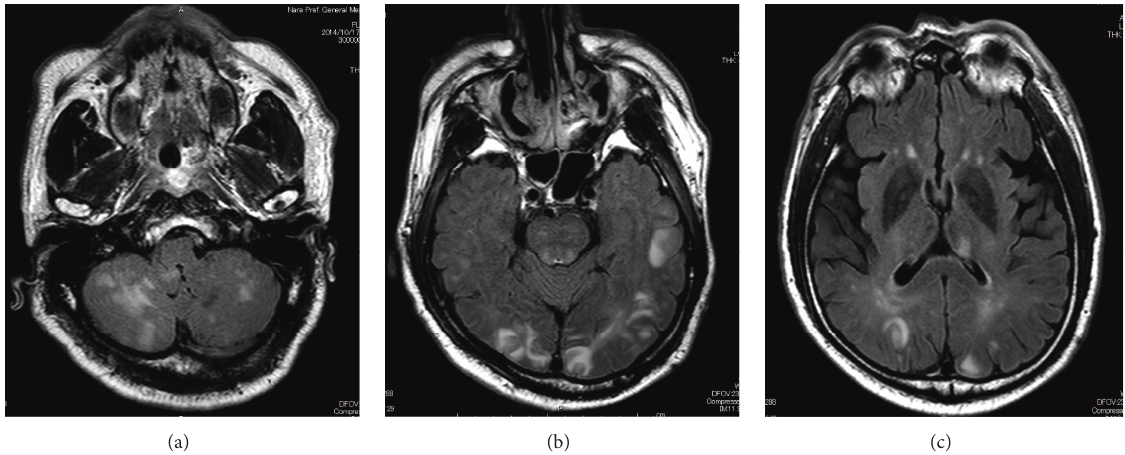
Figure 1: MRI (FLAIR images) of the brain on admission. Multiple high-intensity lesions in the white matter of the occipital and cerebellar lobes, dorsal brain stem, and left thalamus were demonstrated, suggesting RPLS. ((a) Cerebellar lobes lesions, (b) occipital lobes and dorsal brain stem lesions, and (c) left thalamus and occipital lobes lesions.)